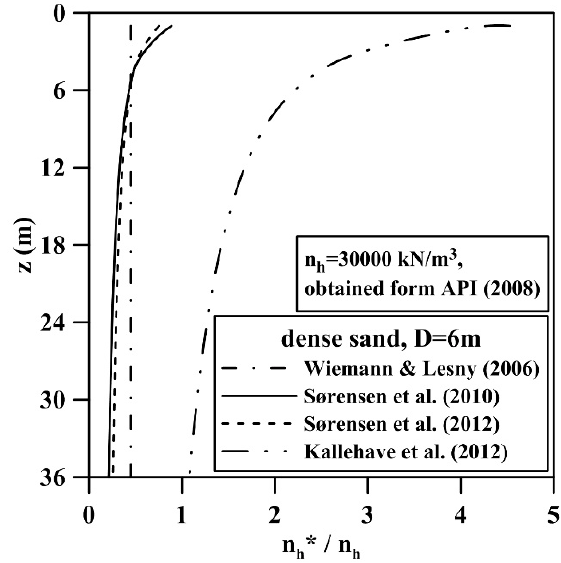
Figure 2. Various (cid:1868) - (cid:1877) curves for different depth values under dense sand, given that (cid:1830) equals 6 m. Figure 2. Various p - y curves for different depth values under dense sand, given that D equals 6